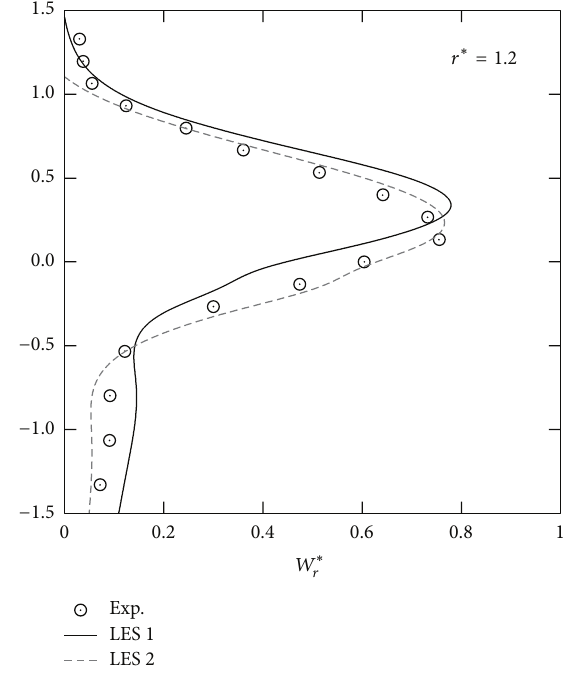
Figure 6: Radial component of the ensemble-averaged mean velocity at 𝑟 ∗ = 1.2